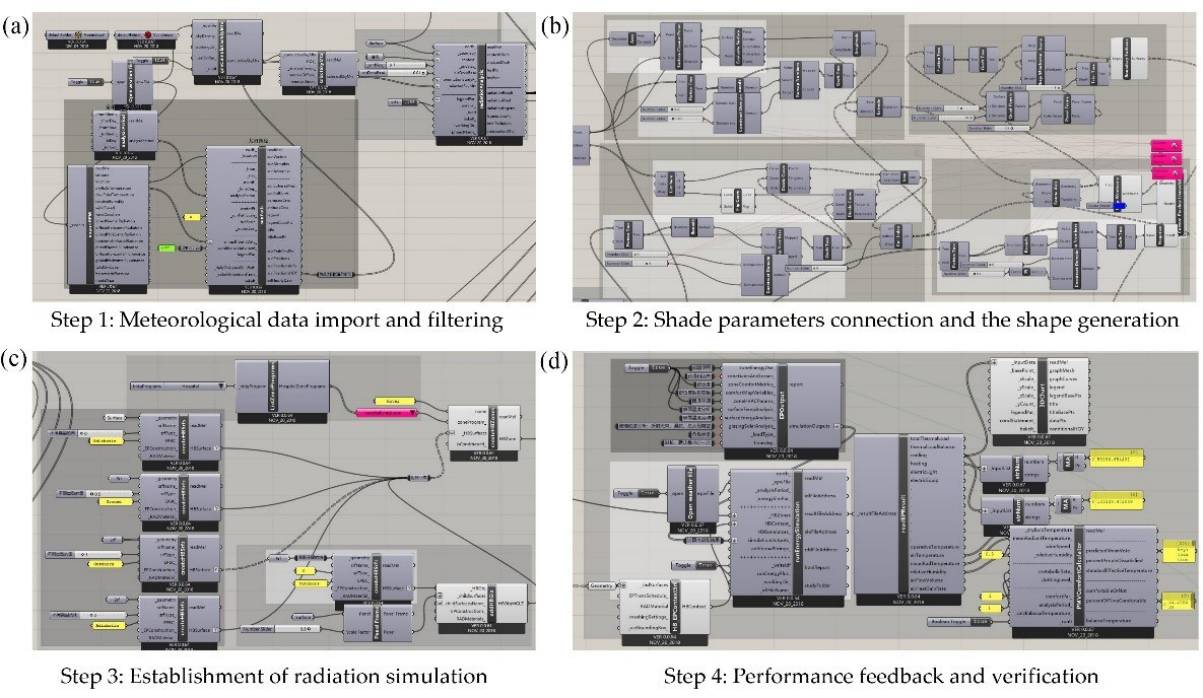
Figure 13. GA for optimizing shading. ( a ) Step 1; ( b ) Step 2; ( c ) Step 3; ( d ) Step 4. (4)